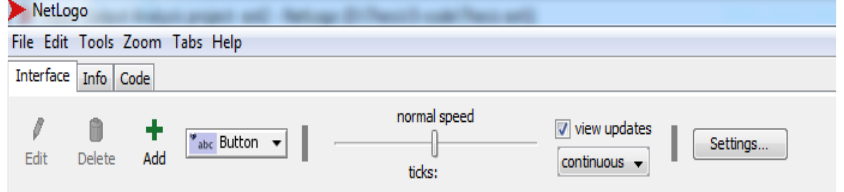
Fig. 6. A view of Netlogo software